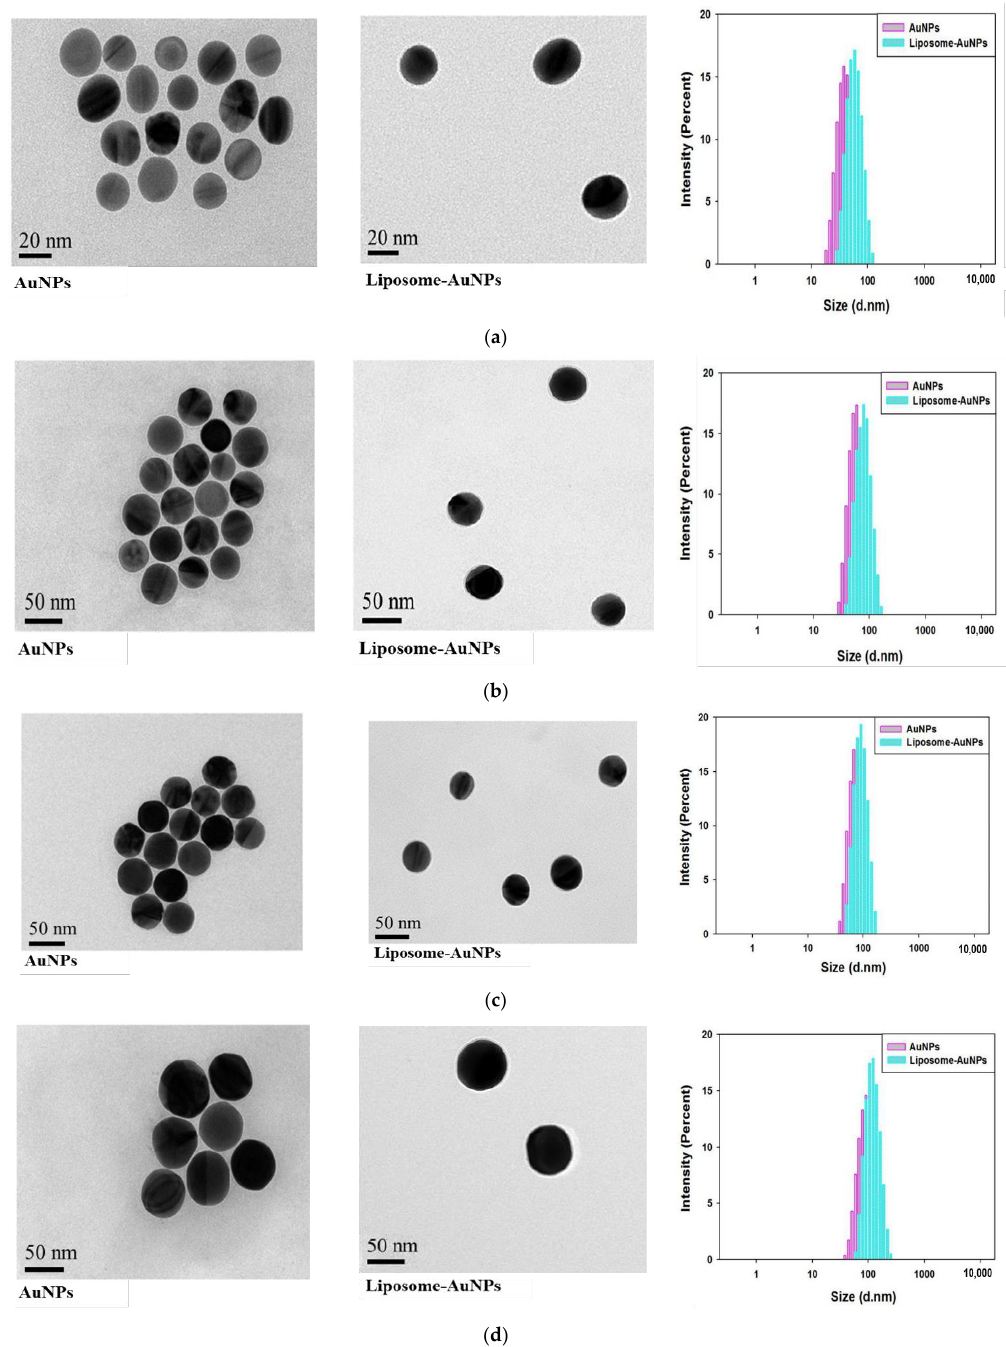
Figure 2. TEM data and DLS data of AuNPs with different sizes and their encapsulation by phospho- lipids: ( a ) 20 nm; ( b ) 40 nm; ( c ) 60 nm; ( d ) 80